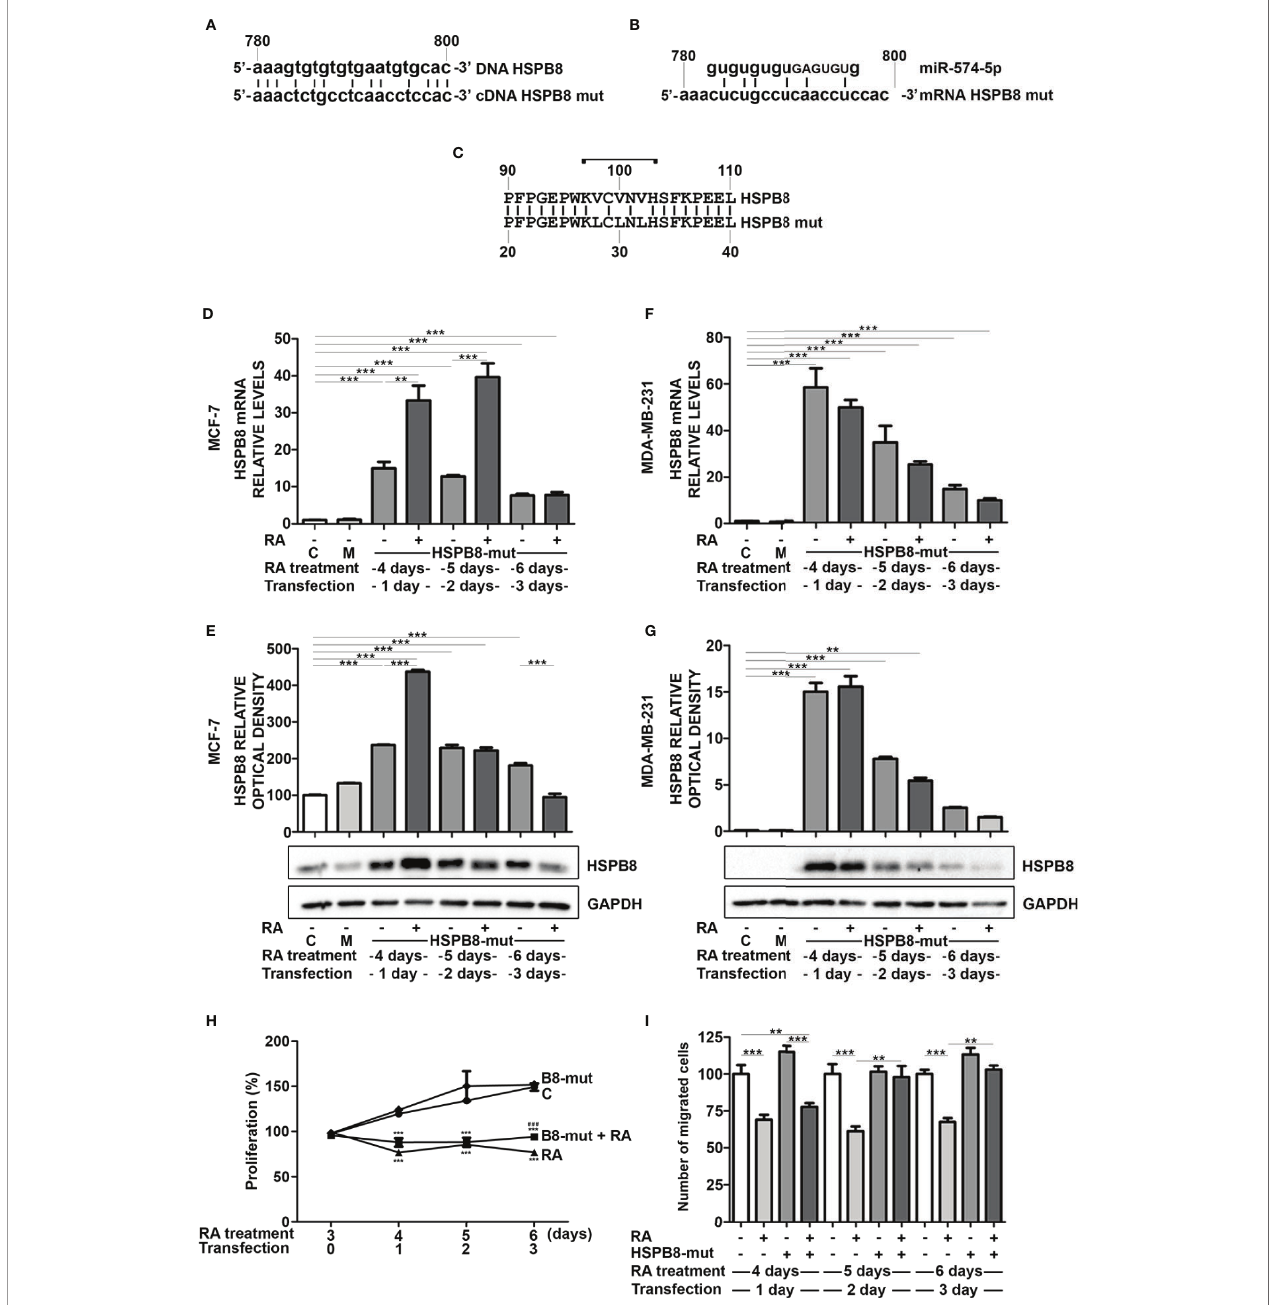
FIGURE 4 | Effects of RA treatment in w fi 0-7 cells overexpressing miR-574-5p mutated HSPB8 variant. (A) Alignment of the ORF region (between 780 and 800bp) of wild-type HSPB8 DNA with mutated HSPB8 DNA. (B) Alignment of miR-574-5p RNAs with mutated HSPB8 mRNA ORF region (between 780 and 800 bp), capital letters indicate the miRNA seed sequence . (C) Alignment of wild-type HSPB8 protein sequences with the mutated one, bracket indicates the aminoacids coded by the mRNA region between 780 and 800 bp. (D) HSPB8 mRNA measured by RT-qPCR analysis in MCF-7 cells. (E) HSPB8 variant protein levels measured by western blot analysis in MCF-7 cells. (F) HSPB8 mRNA measured by RT-qPCR analysis in MDA-MB-231 cells. (G) HSPB8 variant protein levels measured by western blot analysis in MDA-MB-231 cells. For (D – G) untreated cells (C), mock-transfected cells (M) or cells treated up to 6 days with 1 m M RA and transfected at day 3 with the plasmid overexpressing miR-574-5p mutated HSPB8 variant. Analyses were performed at 1, 2 and 3 days after transfection. (H) Proliferation of MCF-7 cells overexpressing the miR-574-5p mutated HSPB8 variant for 3 days and treated with 1 m M RA up to 6 days, values are expressed as percentage on day 3 of RA treatment. (I) Migration of MCF-7 cells overexpressing the miR-574-5p mutated HSPB8 variant for 3 days and treated with 1 m M RA up to 6 days, values are expressed as number of migrated cells (% vs untransfected control). **p < 0.01; ***p < 0.005 in all charts. Graph bars represent the mean of three independent